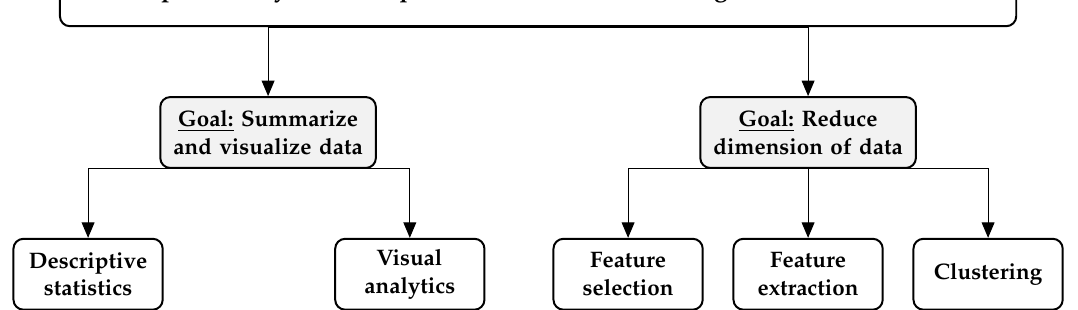
Figure 4. Exploratory data analysis (EDA) goals and their associated techniques/methodological frameworks.